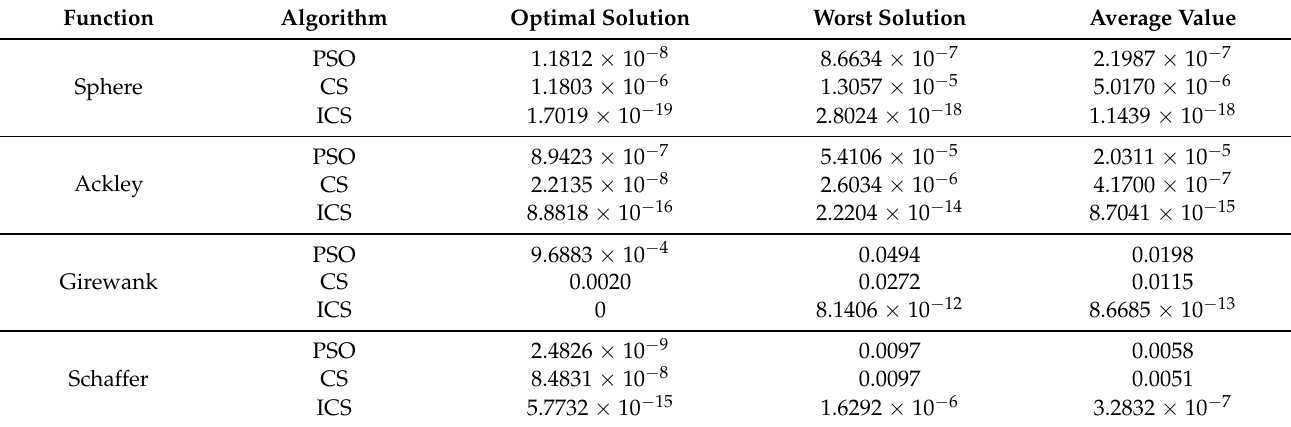
Table 2. Simulation results of test functions.